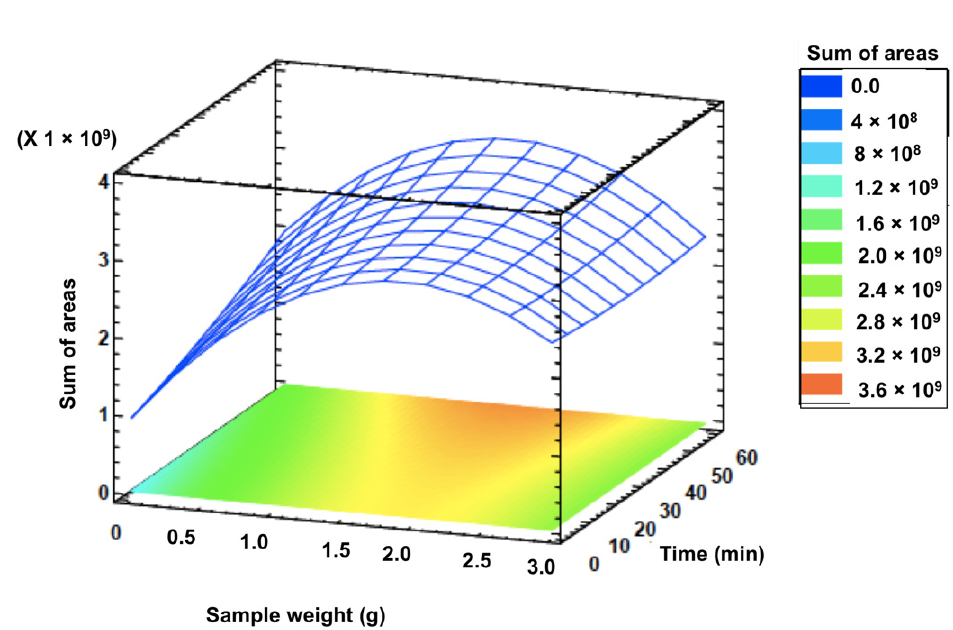
Figure 5. Surface response and contour plot for the interaction between sample weight and time when temperature is fixed at the optimum level.